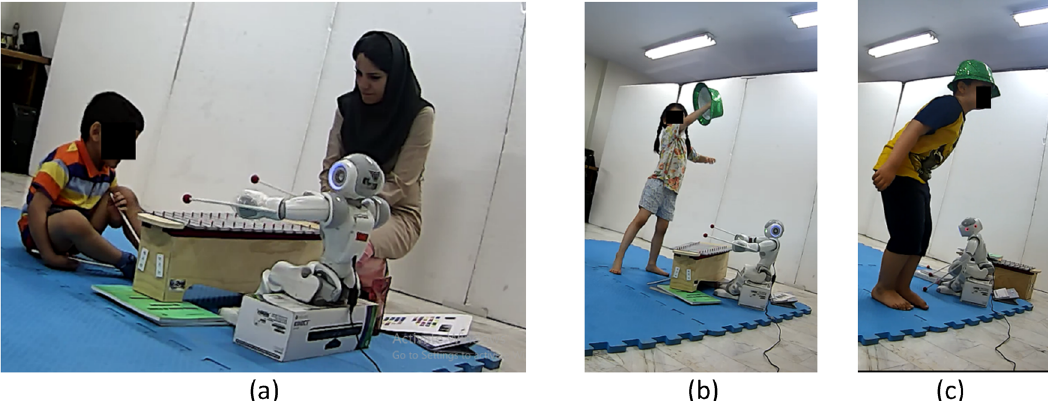
Figure 3: Snapshots of three of the participants playing the real and virtual xylophones in the intervention sessions: ( a ) considering bars ’ colors, the child should imitate Nima ’ s strikes ( i.e. Game #3 - a ) . ( b ) The child is imitating the robot ’ s strikes on the virtual xylophone ( i.e. Game #10 - a ) . ( c ) The child did not do the tasks appropriately based on the instructions of playing the virtual xylophone ( i.e. Game #10 - a )